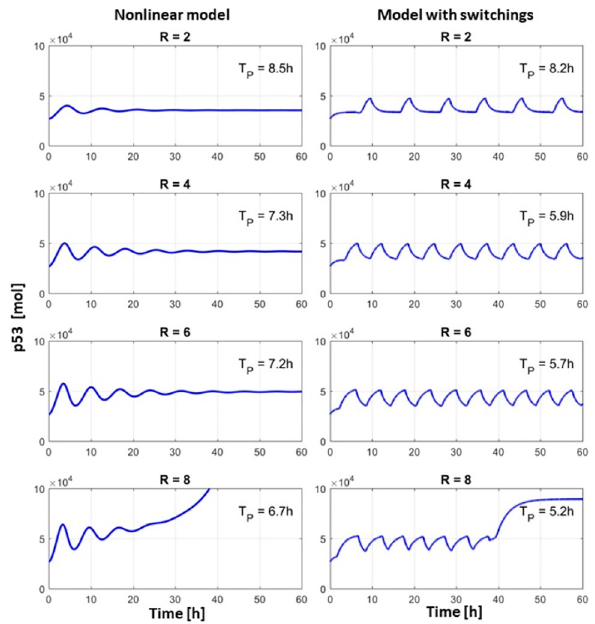
Fig 2. Time courses of nonlinear model and model with switching for different stress levels. T oscillations.